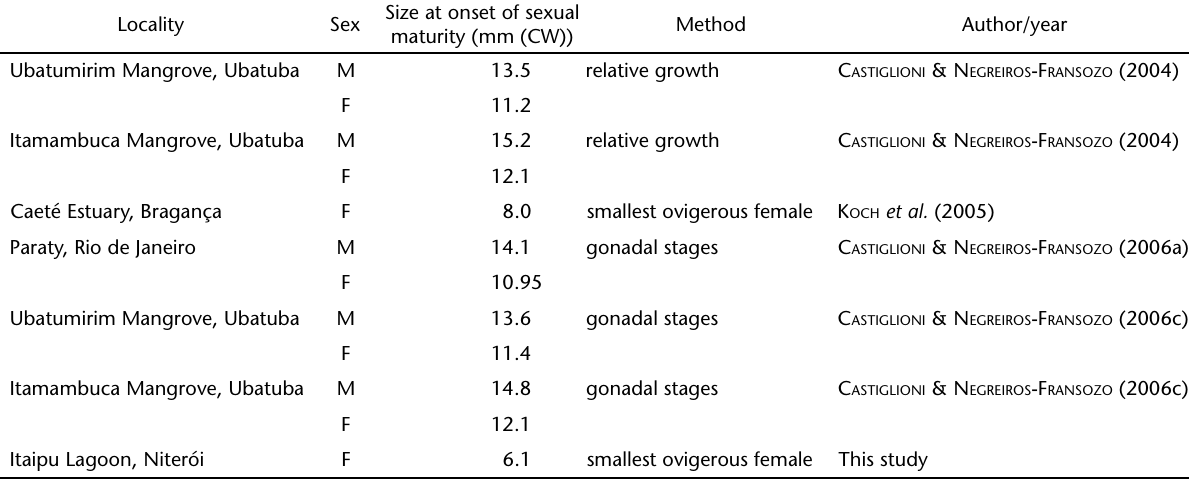
Table V. Size at onset of sexual maturity in U. rapax from different localities in Brazil. Locality